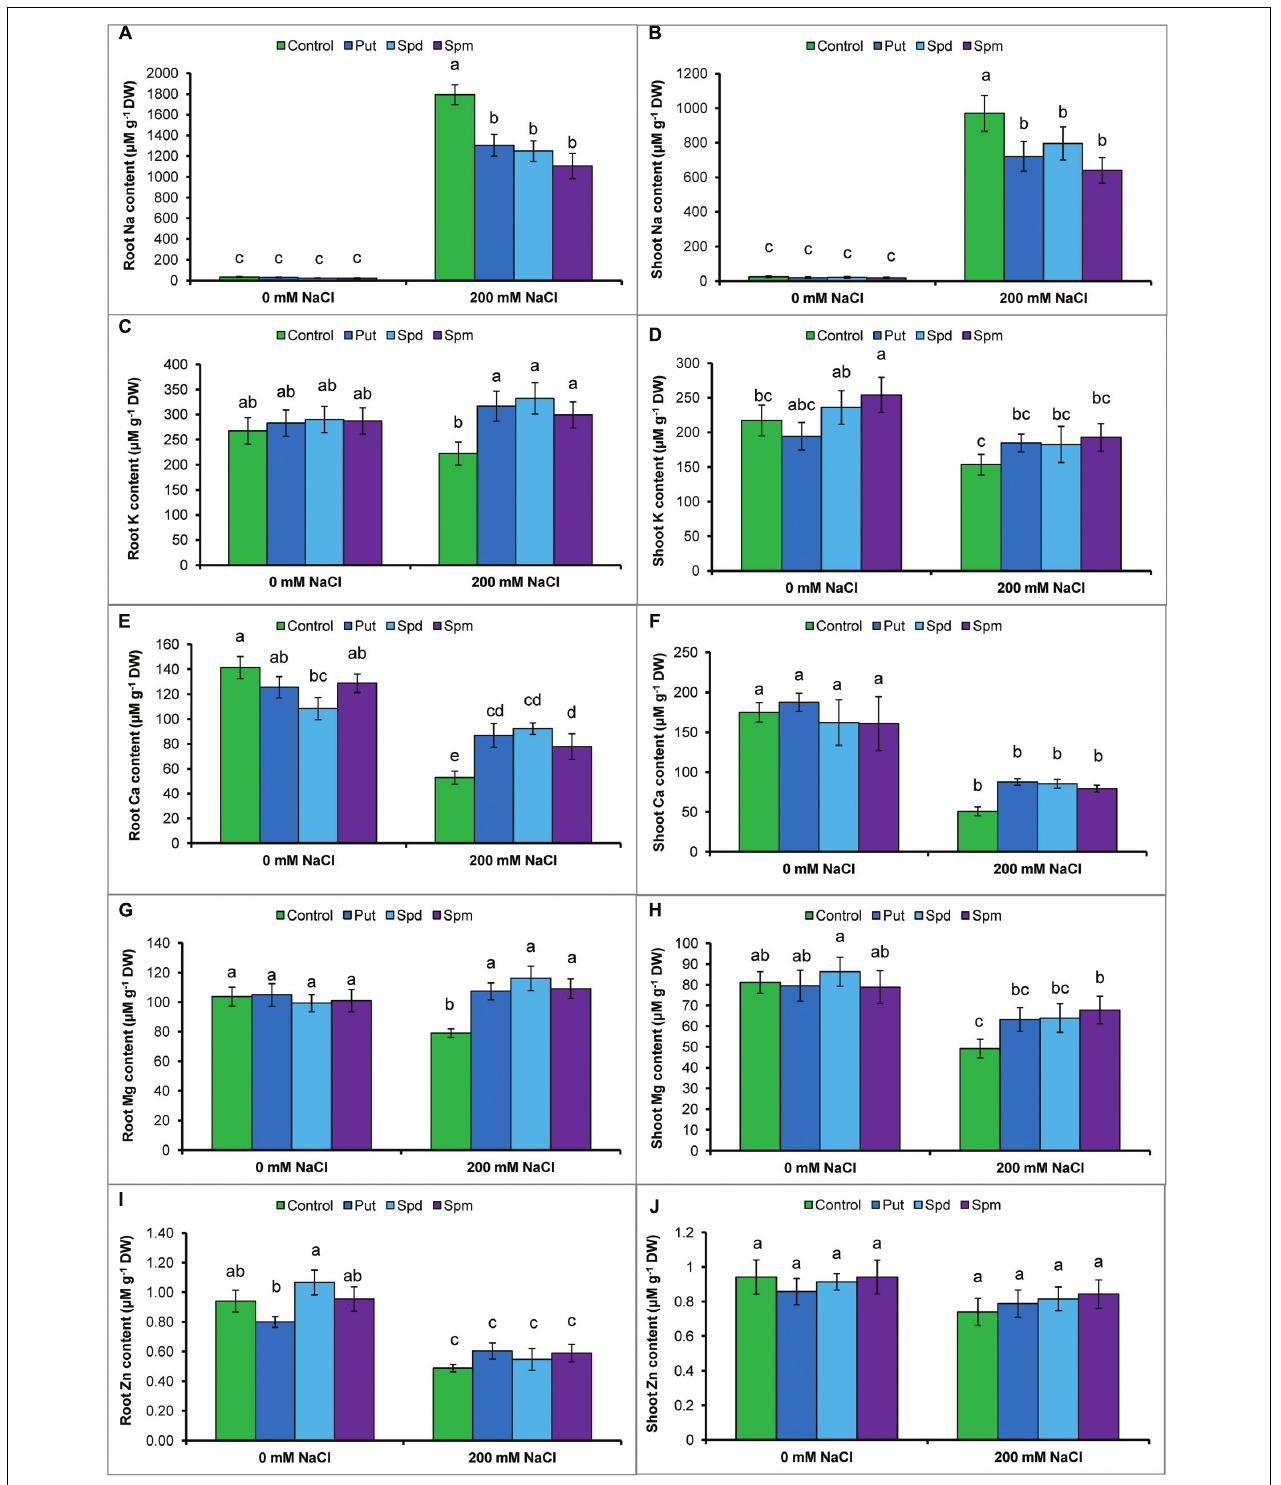
FIGURE 1 | Effect of exogenous polyamines on Na uptake and nutrient homeostasis in mung bean seedlings under salt stress (NaCl, 200 mM). Root Na (A) , shoot Na (B) , root K (C) , and shoot K (D) root Ca (E) , shoot Ca (F) , root Mg (G) , shoot Mg (H) , root Zn (I) , and shoot Zn (J) contents. Here, Put, Spd, and Spm indicate putrescine (0.2 mM), spermidine (0.2 mM), and spermine (0.2 mM), respectively. Mean ( ± SD) was calculated from three replicates for each treatment. Bars with different letters are significantly different at P ≤ 0.05 applying Tukey’s HSD test.